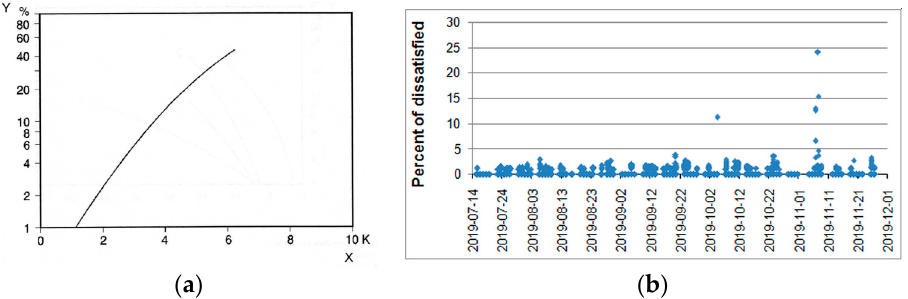
Figure 17. ( a ) Local thermal discomfort caused by vertical air temperature difference [19]; ( b ) calculated percent of dissatisfied during measurement period.